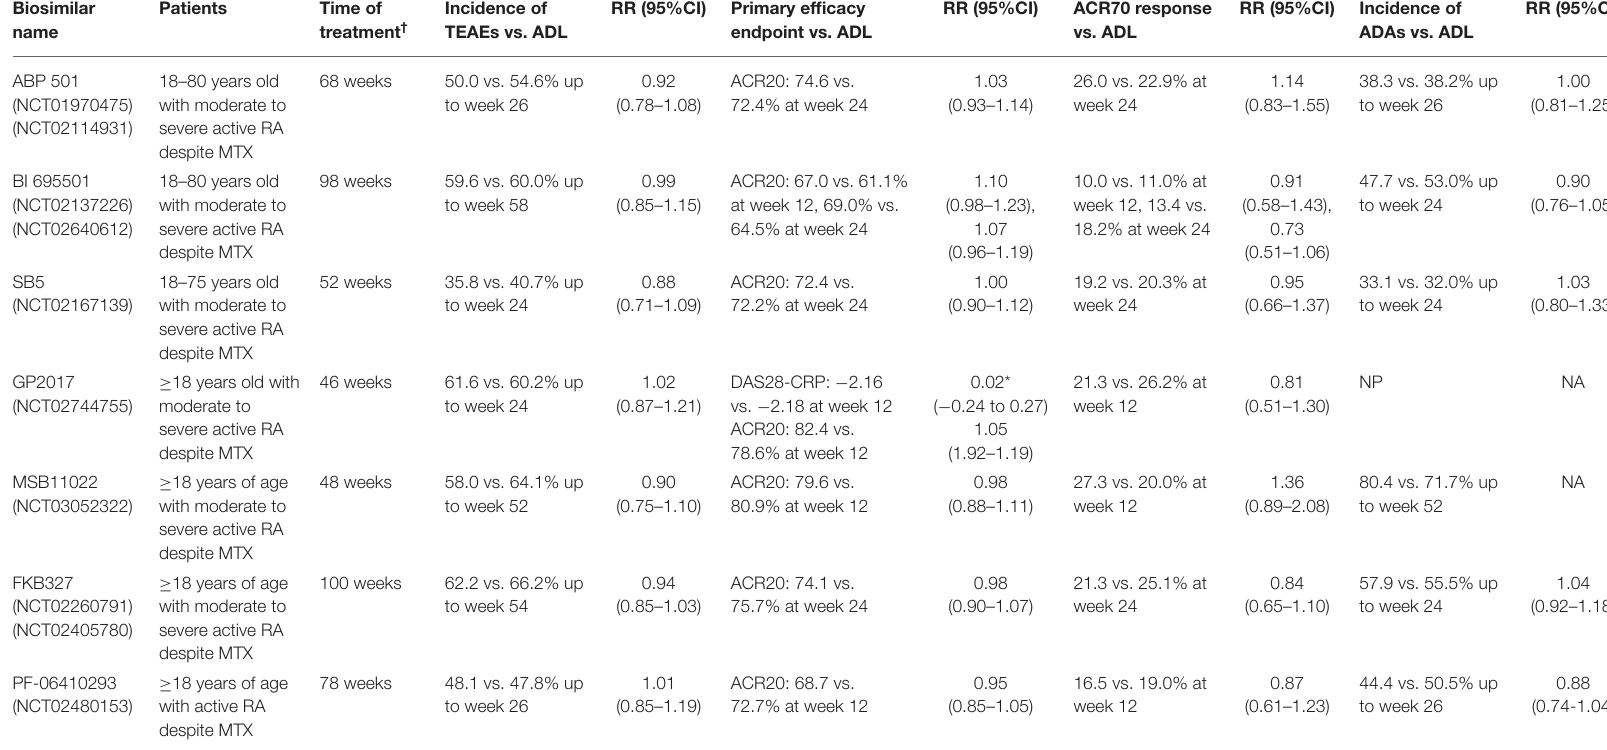
TABLE 2 | The summary of characteristic and key endpoints of each pivotal